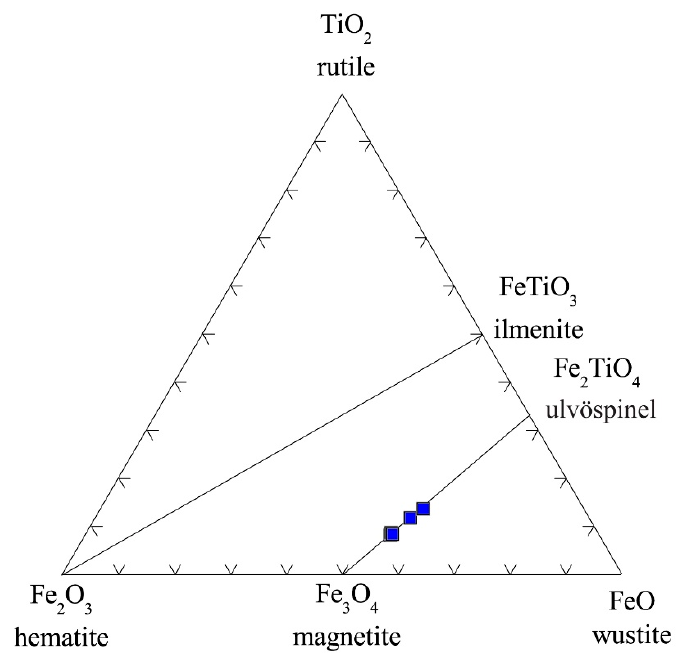
Figure 5. Fe 2 O 3 -TiO 2 -FeO ternary diagram [53] for opaque oxides of the selected MEGT volcanic rocks.